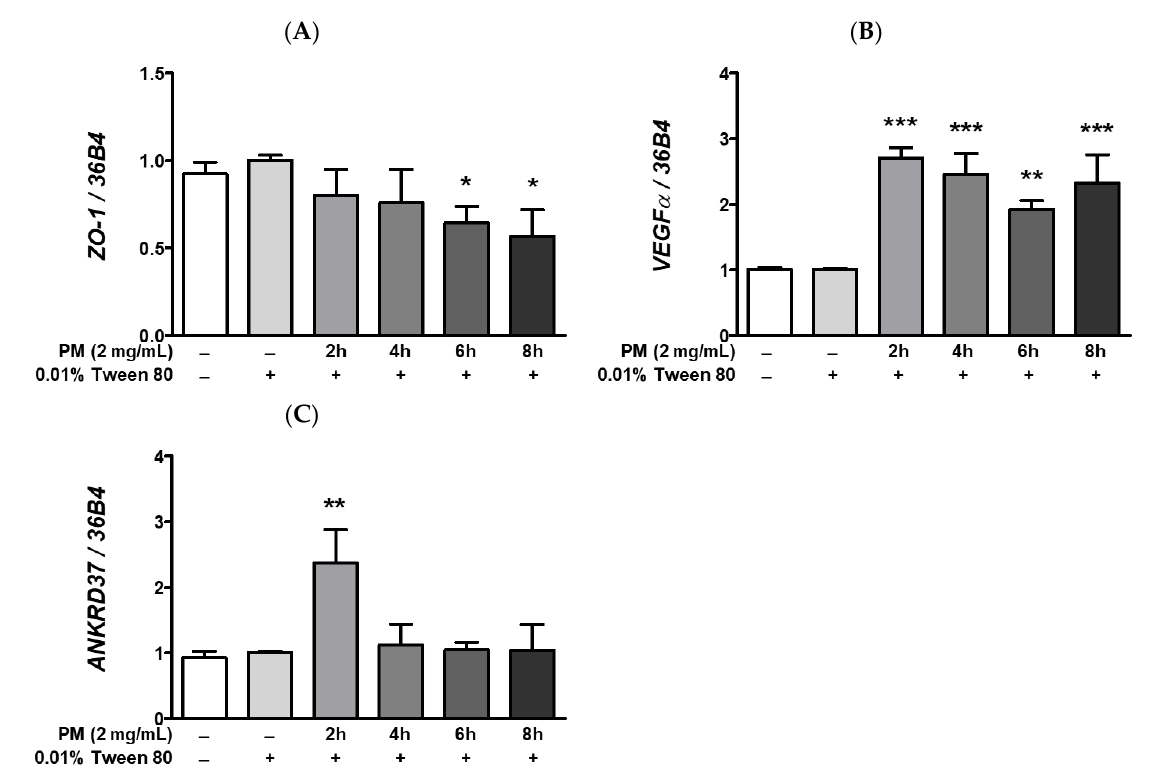
Figure 6. Effect of PM on hypoxia response-related mRNAs expression in ARPE-19 cells. Cells were treated with 2 mg/mL of PM for 0–8 h and 0.01% Tween-80 was used as a vehicle control. The mRNA levels of ( A ) ZO-1 , ( B ) VEGF α , and ( C ) ANKRD37 were measured by qRT-PCR, using 36B4 as the reference gene for normalization. Data are depicted as mean ± SD ( n = 3). Data were analyzed using one-way ANOVA followed by Tukey’s multiple comparison (* p < 0.05, ** p < 0.01, *** p < 0.001). All comparisons were made against the vehicle control group. Abbreviations used in Figure: PM; particulate matter, ZO-1 ; zonula occludens-1 , VEGF α ; vascular endothelial growth factor alpha , ANKRD37 ; ankyrin repeat domain 37 .